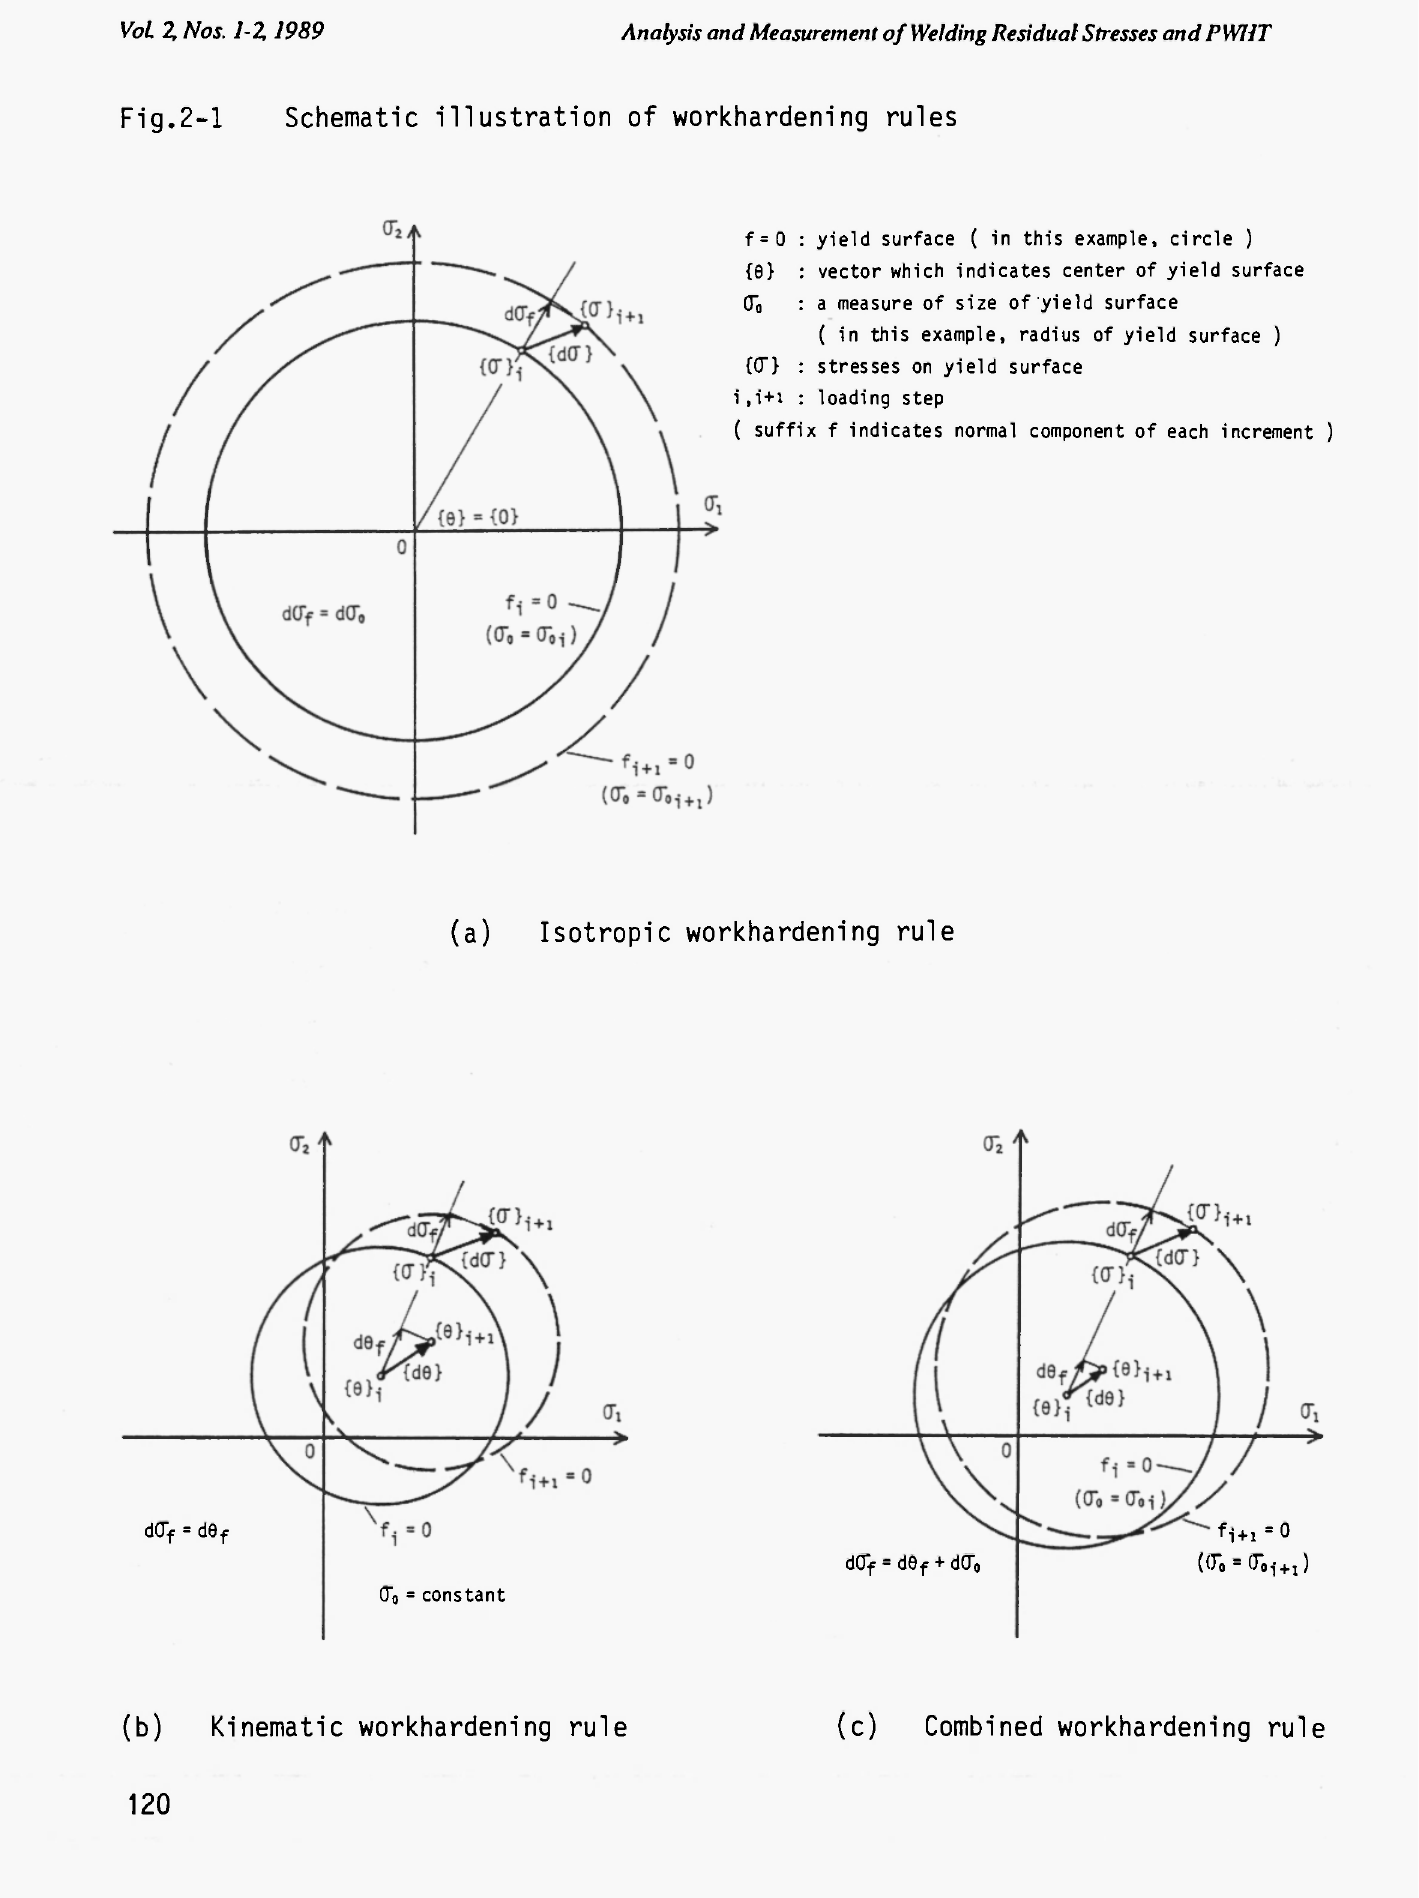
Fig.2-1 Schematic illustration of workhardening